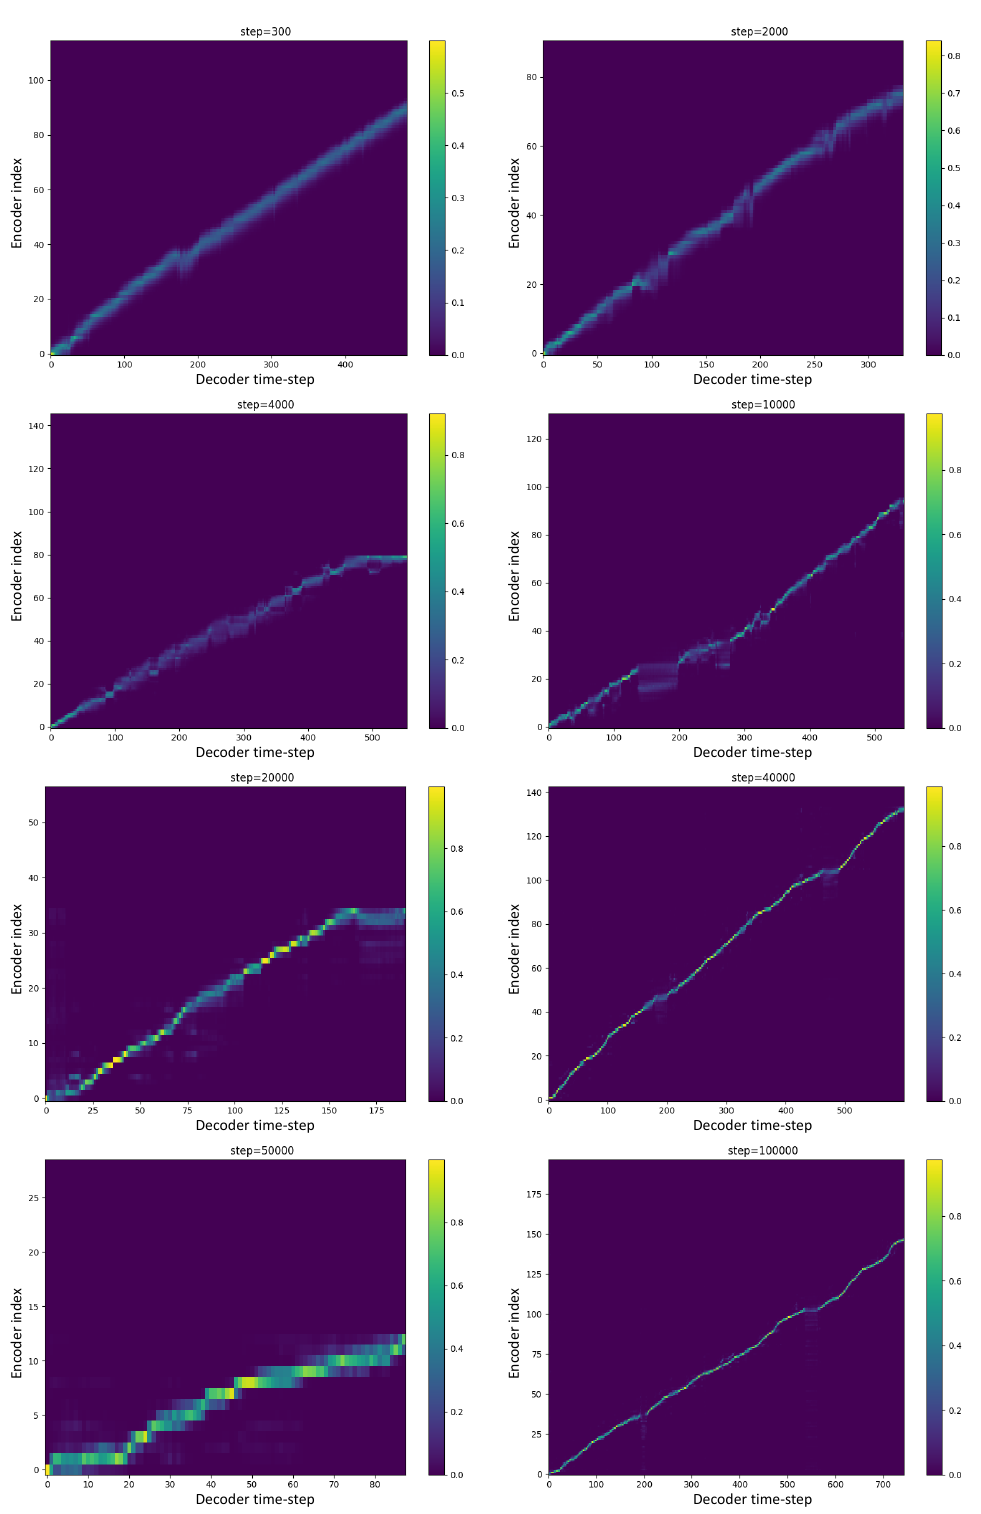
Figure A2. Attention plot during training Tacotron2-GST-LSA with decaying guided